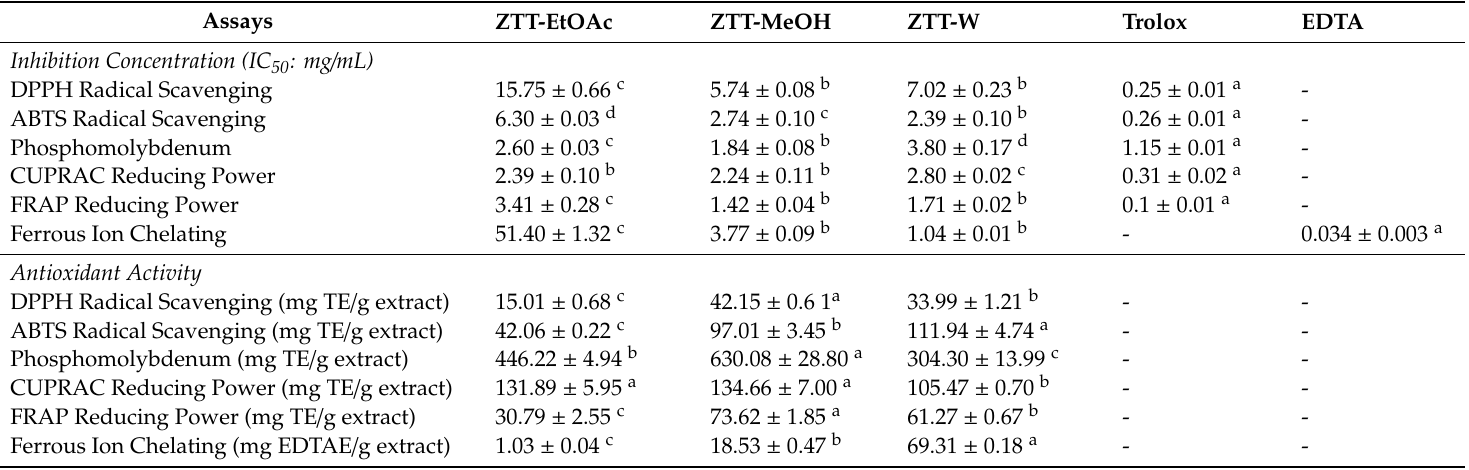
Table 3. Antioxidant activities of standards and the extracts from Z. taurica subsp. taurica x